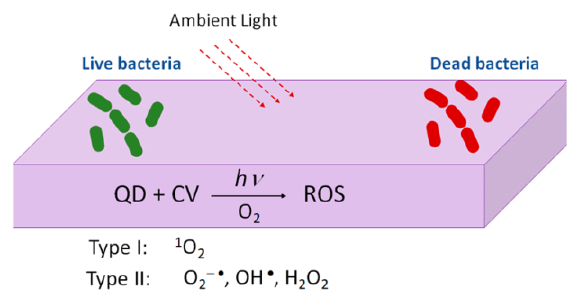
Figure 9. Figure illustrating the mechanism of photoactivable polymers with visible light combined with QDs +